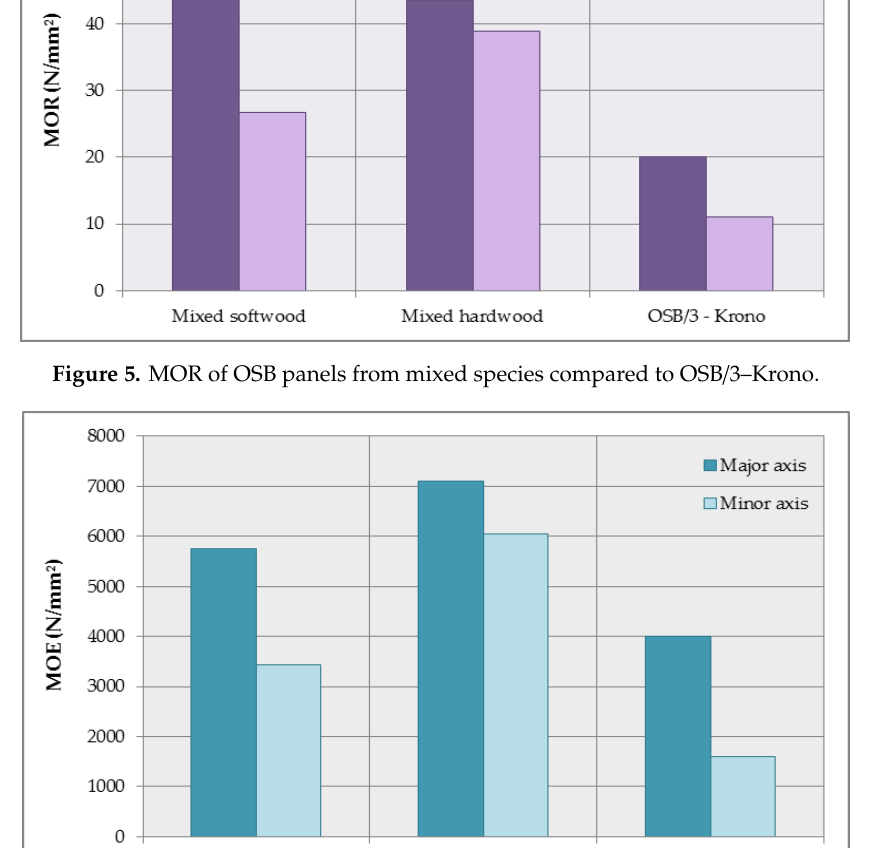
Figure 6. MOE of OSB panels from mixed species compared to OSB/3–Krono .